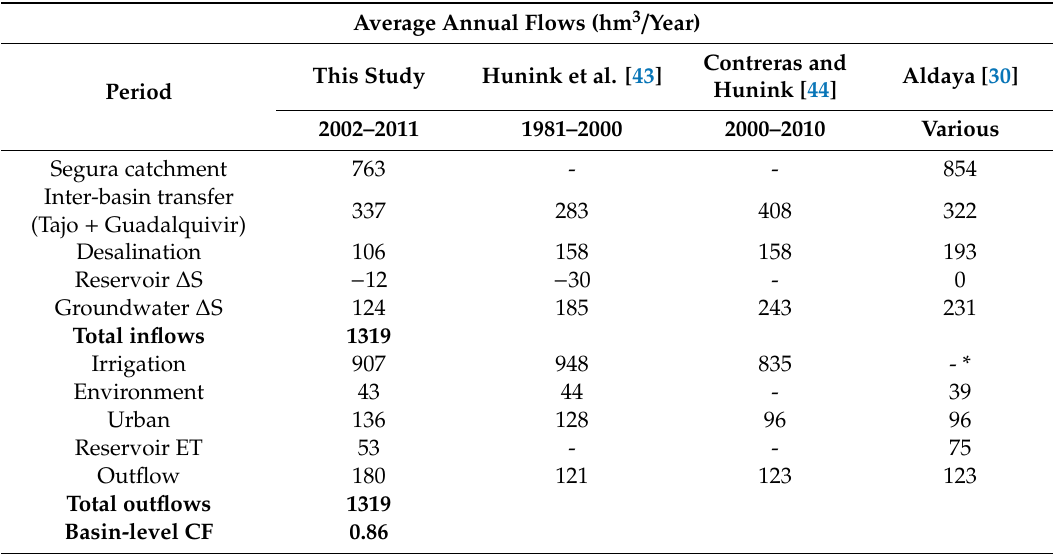
Table 1. Blue water cycle of the Segura River Basin ( ∆ S = storage change, CF = Consumed Fraction).